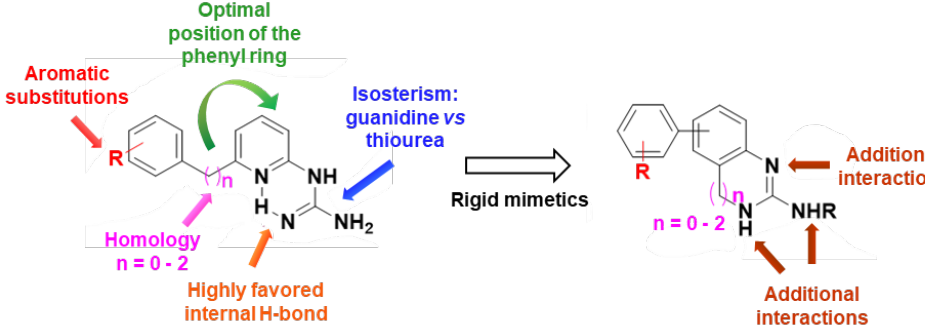
Figure 2. Pyridinyl-guanidine template (hit compound 1a) and strategy for SAR.